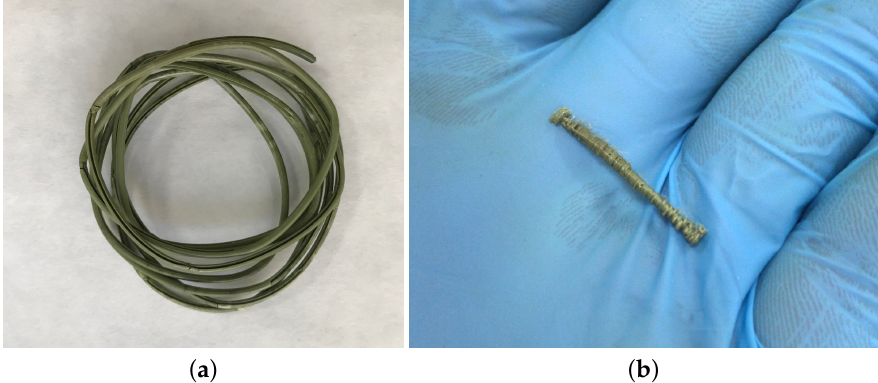
Figure 11. Pictures of the polymeric samples used for the evaluation of ADC and AOC ( a ) 150 cm long PLA filament after impregnation. ( b ) Sample used for the biocapacity tests of printed